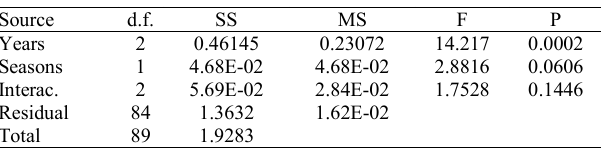
Table 3. Permutational multivariate analysis of variance (PERMANOVA) on the basis of Bray-Curtis dissimilarities for the distribution of three species of Chirostoma in the Lake Chapala in three years (1999, 2000, and 2005) and two seasons per year (rainy and dry).